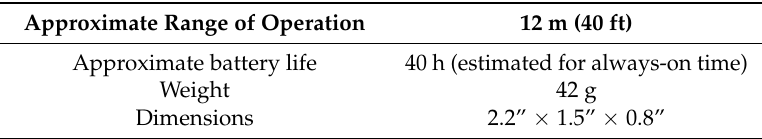
Table 1. Specifications of the wireless gait analysis